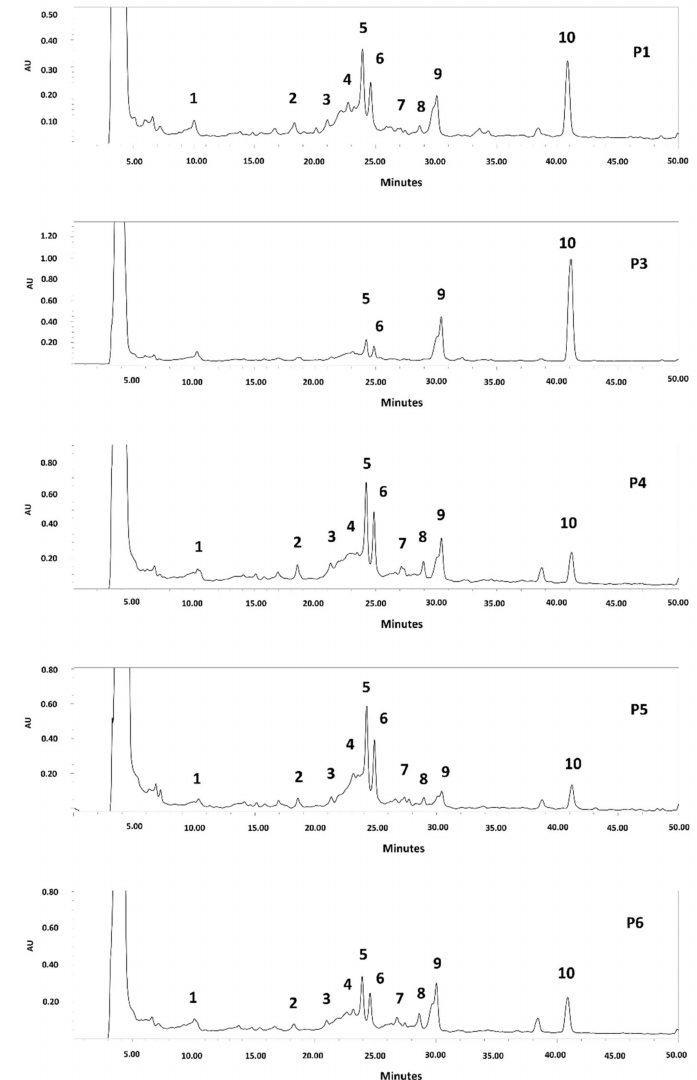
Figure 2. HPLC chromatogram of polyphenols from P. alba seed flour (Clones P1–P6). Detection: UV 254 nm. Compounds: 1: isoschaftoside hexoside; 2: schaftoside hexoside; 3: Vicenin II (apigenin- di- C -hexoside)/isomer; 4: vicenin II/isomer; 5: isoschaftoside (apigenin- C -hexoside- C -pentoside); 6: schaftoside; 7: unknown; 8: vitexin; 9: isovitexin; 10: